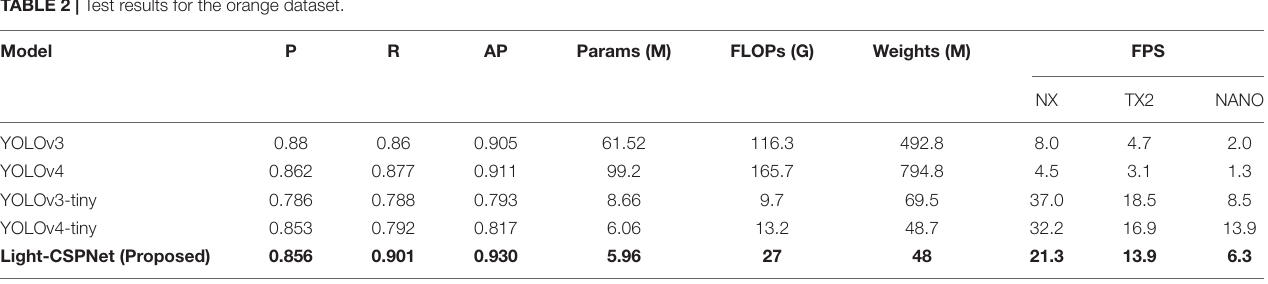
TABLE 2 | Test results for the orange dataset.